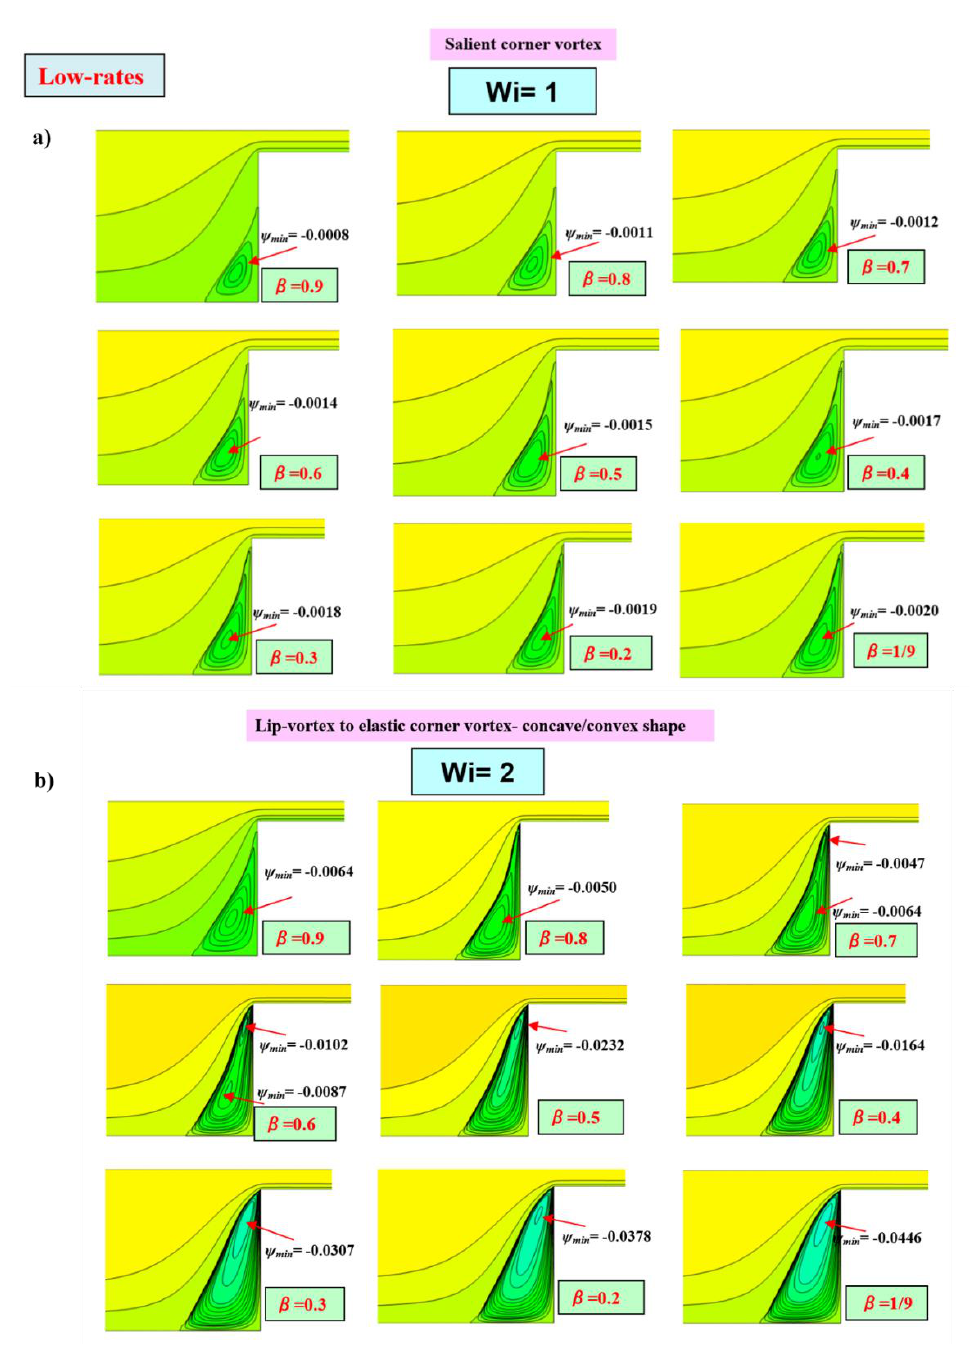
Figure 7. Streamlines; α aspect = 8; low flow-rates: ( a ) Wi = 1, ( b ) Wi = 2; swIM [ L = 5, λ D = 0.075]; 1 / 9 ≤ β ≤ 0.9.